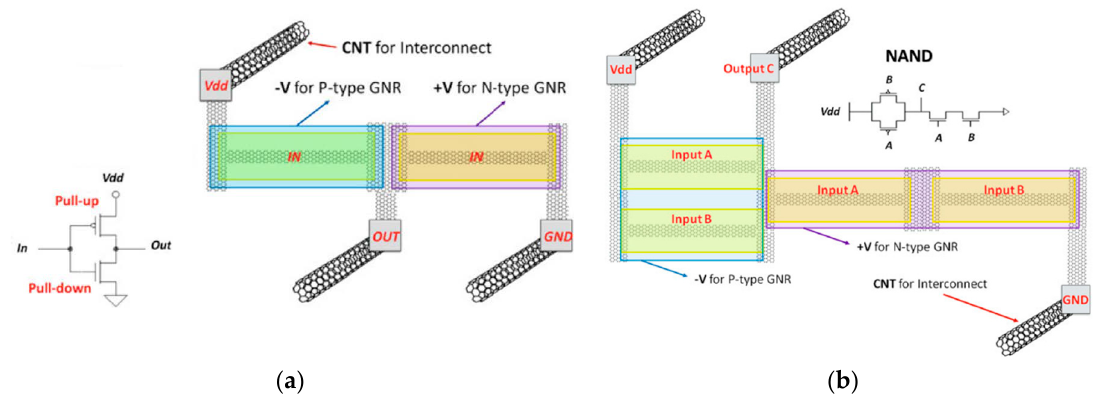
Figure 3. Examples of GNR FET logic gates [10]: ( a ) NOT. ( b ) NAND. Copyright.